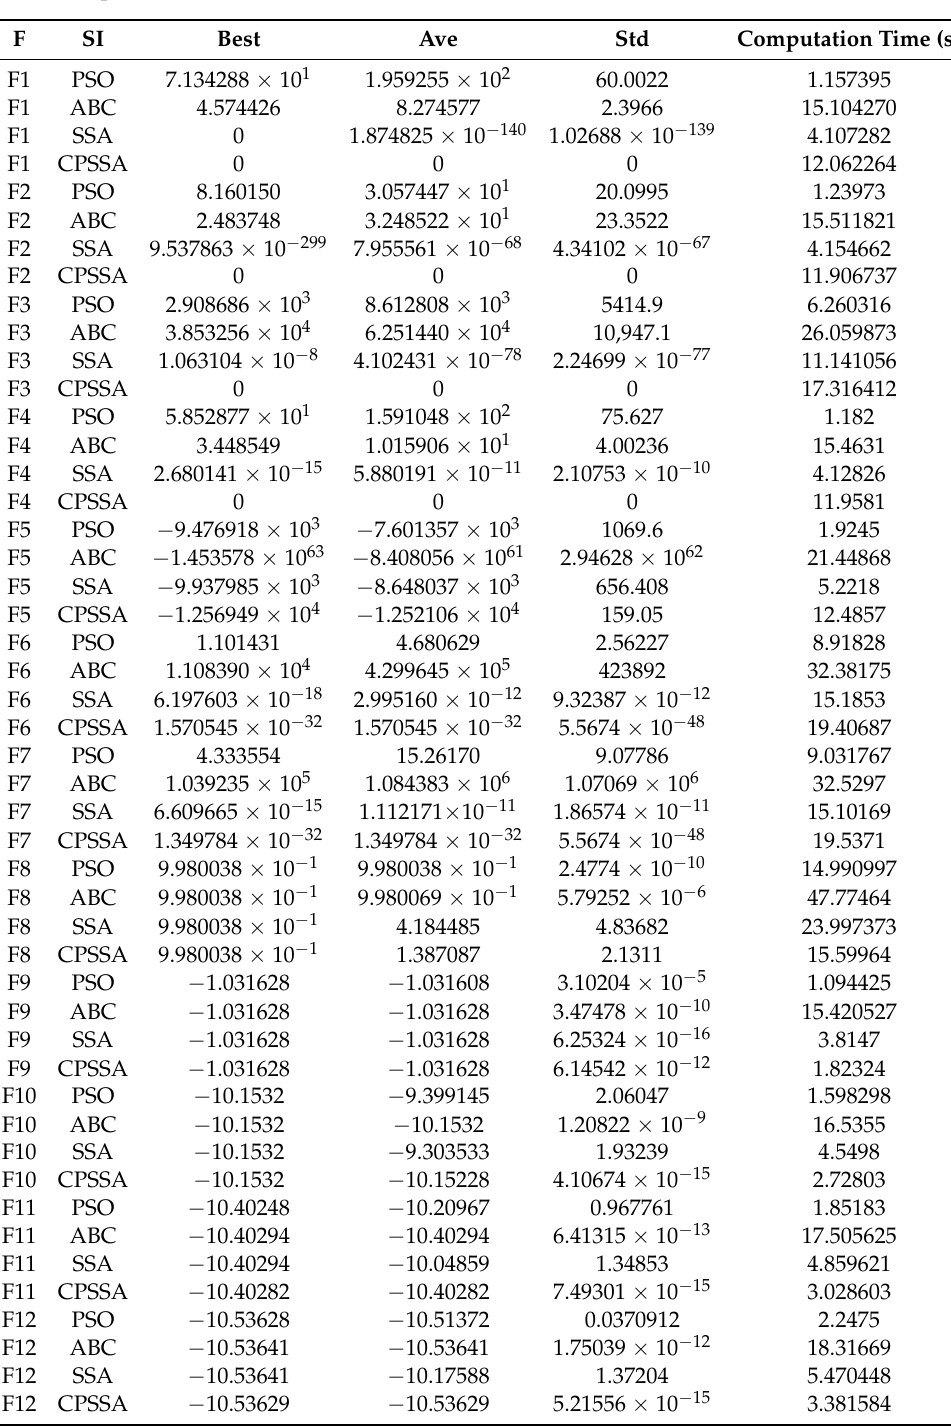
Table 3. Experiment results of test